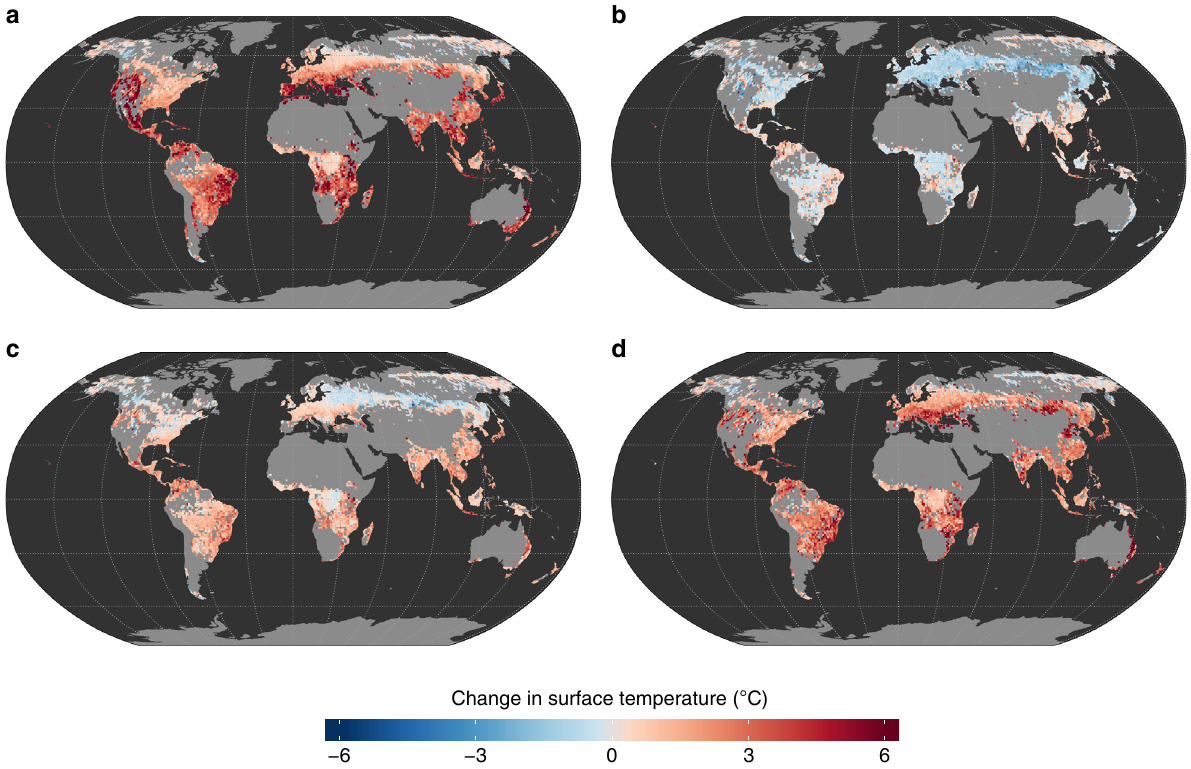
Fig. 1 Potential changes to surface temperatures caused by deforestation. Panels describe the expected average annual change of a day-time and b night- time clear sky land surface temperature (LST), of c mean LST (de fi ned as the average between a and b ) and of d LST diurnal amplitude (de fi ned as the difference between a and b )